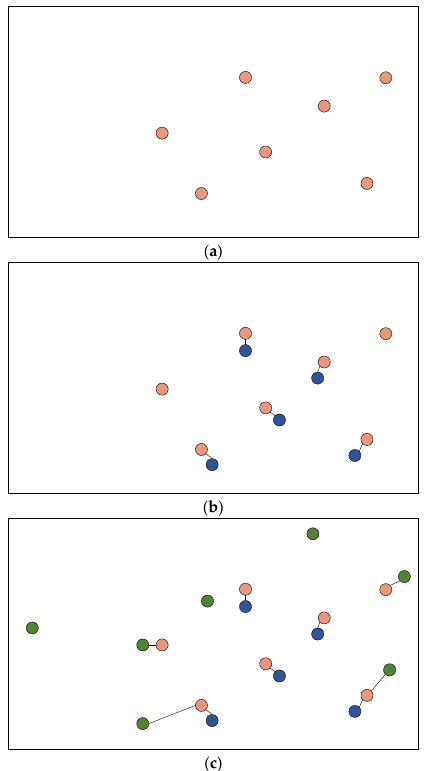
Figure 1. ( a ). Semantic span of the Sciatica subreddit (light brown). The semantic span of Sciatica encompasses 7 centroids. Edges between two nodes represent similarities ≥ 0.9. ( b ). Semantic span of the Sciatica and backpain (blue) subreddits. The semantic span of backpain encompasses 5 centroids. Edges between two nodes represent similarities ≥ 0.9. ( c ). Semantic span of the Sciatica , backpain , and CrohnsDisease (green) subreddits. The semantic span of CrohnsDisease encompasses 7 centroids. Edges between two nodes represent similarities ≥ 0.9. Figure 2 shows the similarity graph of the semantic spans of all subreddits in the form of a petal graph. In this petal graph, each sub-graph represents one connected component of the similarity graph. Moreover, each of these sub-graphs is characterized by the top-10 TFIDF scoring tokens of the subset of documents that belong to it. Similar to the previous sequential overlap of semantic spans, we observe that certain sub-graphs encompass at least a node from all subreddits (suggesting that that sub-graph is a concern common to all subreddits), others encompass only a subset of subreddits (suggesting that those subreddits have that concern in common, but other subreddits do not), and others are composed of a single subreddit (suggesting that that concern is exclusive to that subreddit, a point of acute dissimilarity).